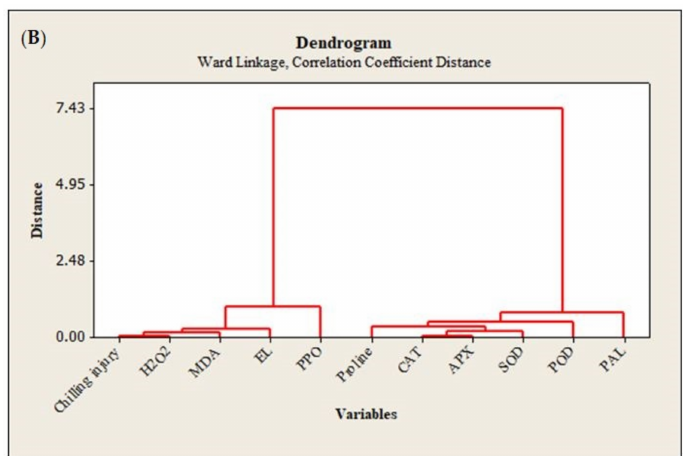
Figure 7. ( A ), Hierarchical clustering analysis (HCA) of the cultivars and temperatures; ( B ), parameters of blood orange cultivars (‘Moro’, ‘Tarocco’, ‘Sanguinello’ and ‘Sanguine’) during cold storage at 2 and 5 ◦ C and 90% relative humidity (RH) plus 2 days at 20 ◦